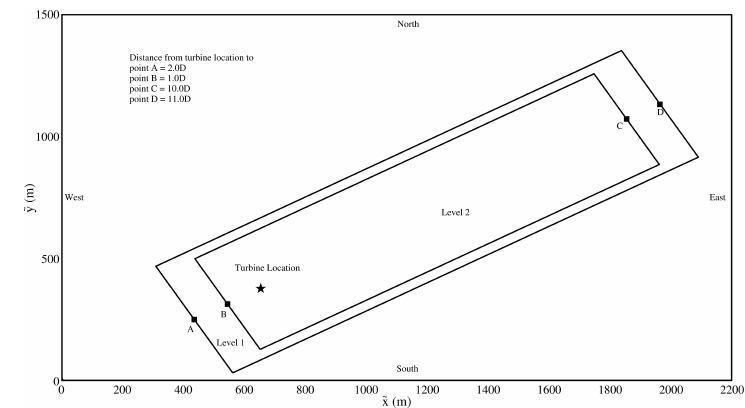
Figure 4. A schematic showing the computational domains for the atmospheric boundary layer (precursor) and the main (wind turbine) simulations. The entire box in ( a ) is the domain for precursor calculations; the shaded area shows the smaller domain for wind turbine calculations. In ( b ), Points A–D are lateral midpoints of the rectangular refinement